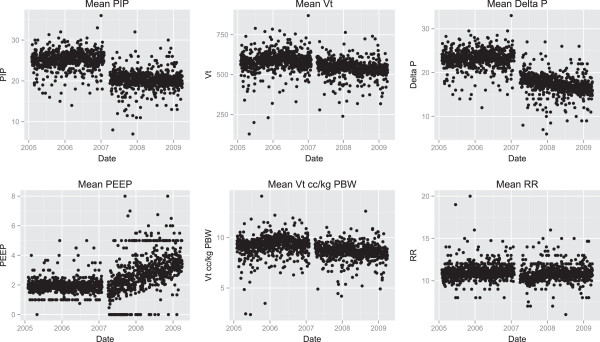
Scatterplots of average ventilation parameters over 2 months before and 2 months after new machines are integrated into practice. Significant changes were seen in peak inspiratory pressure (PIP) and drive pressure (∆P). Vt = Tidal Volume, PEEP = positive end expiratory pressure, RR = respiratory rate.